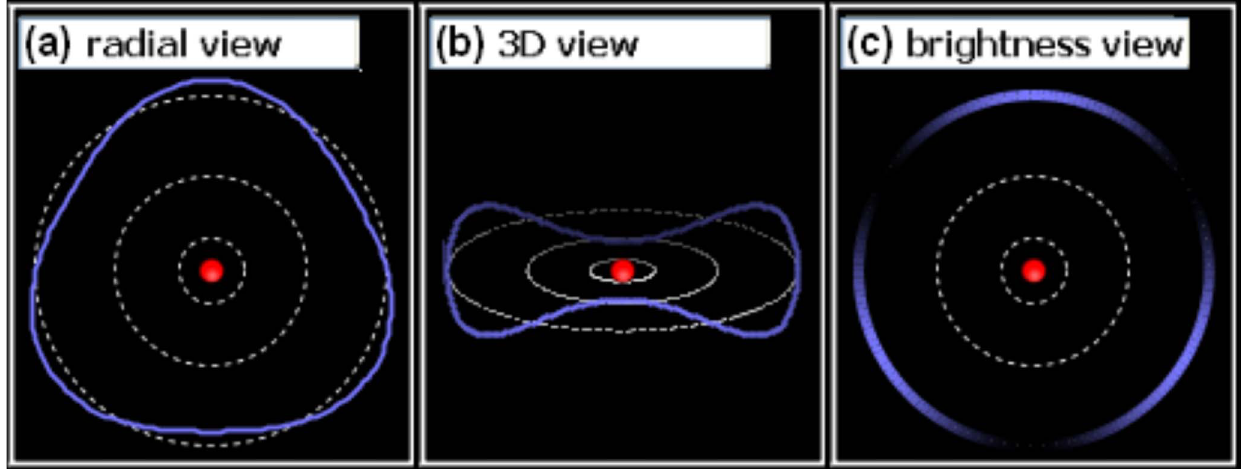
FIG. 11. (cid:1) Color (cid:2) Three representations of the de